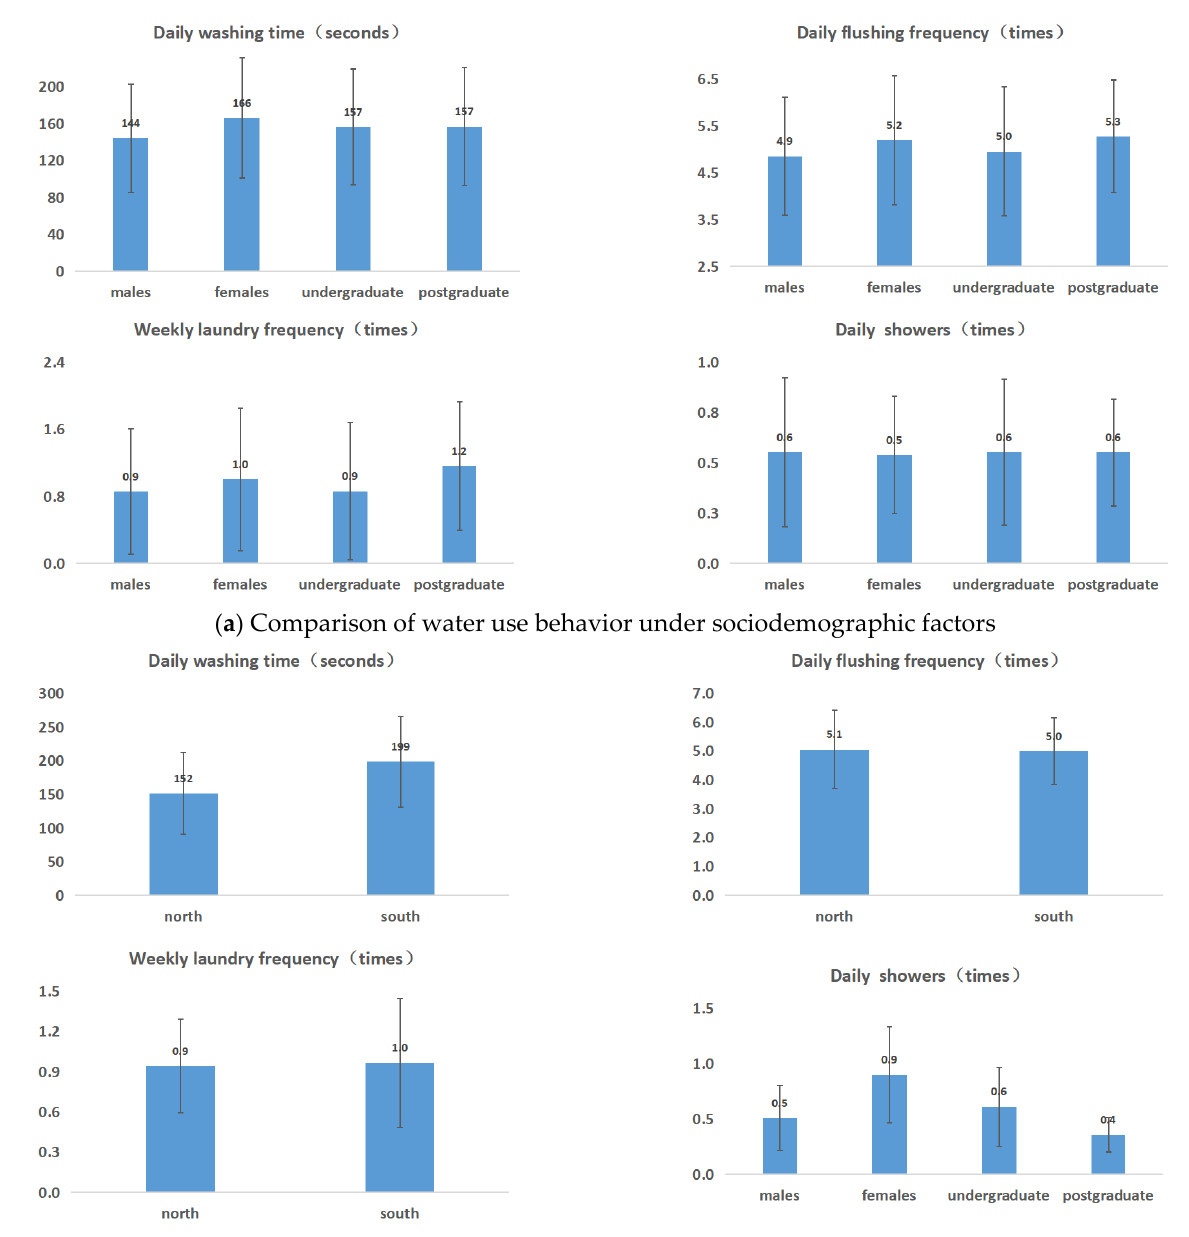
Figure 3. Comparison of different water use behavior under different influencing factors.